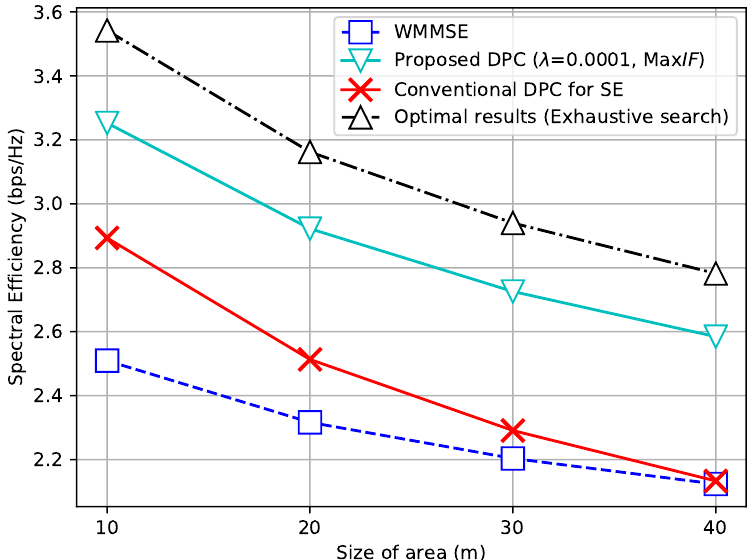
Figure 11. Average spectral efficiency of the conventional and proposed schemes for α = 3.8 in Nakagami- m fading channels when m =